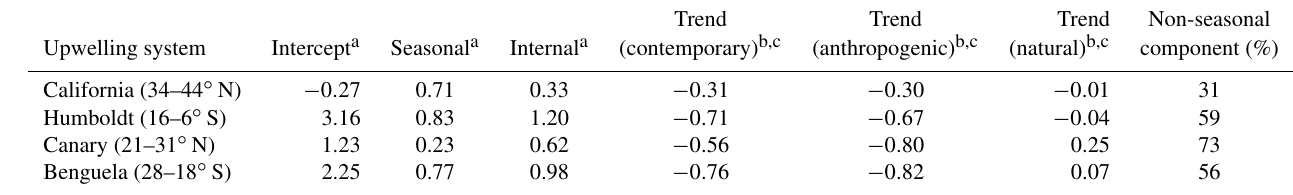
Table 1. Statistics for air–sea CO 2 fluxes in the CalCS, HumCS, CanCS, and BenCS from 1920 to 2015. The seasonal component is computed as the standard deviation of the ensemble monthly climatology after removing a fourth-order polynomial fit to remove the long-term trend. The internal component is computed as the ensemble mean standard deviation of the anomalies. The trend is computed as the first-order ordinary least squares regression coefficient for the contemporary (total), anthropogenic, and natural CO 2 fluxes. The intercept is derived from this linear regression. The non-seasonal component represents the fraction of total variability (seasonal plus internal) to which the internal component contributes.